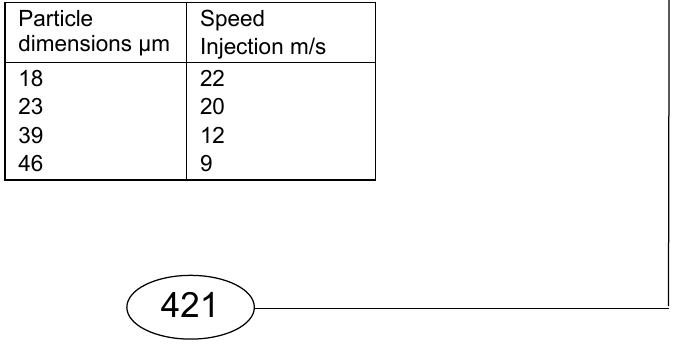
Table 1 – Optimal injection speeds for Al 2 O 3 particles of individual